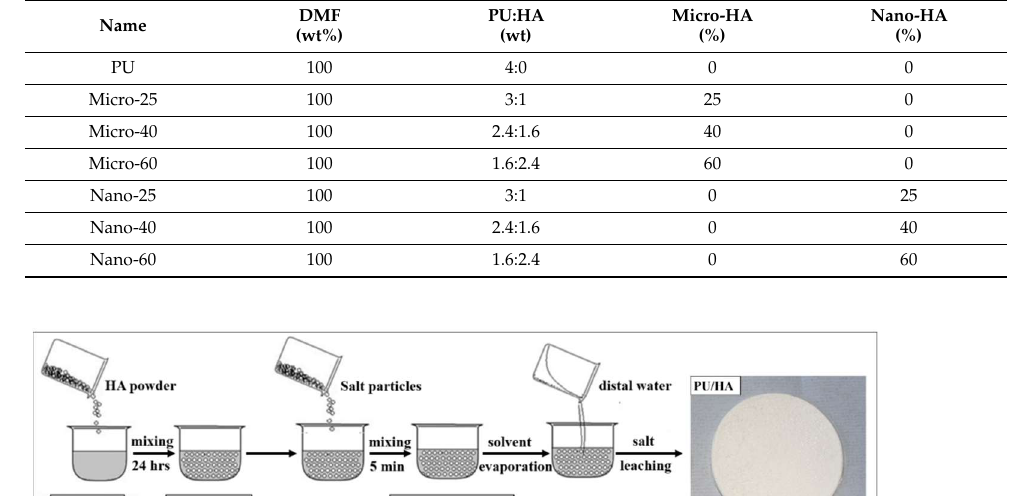
Table 2. Components of PU and PU-HA solutions.